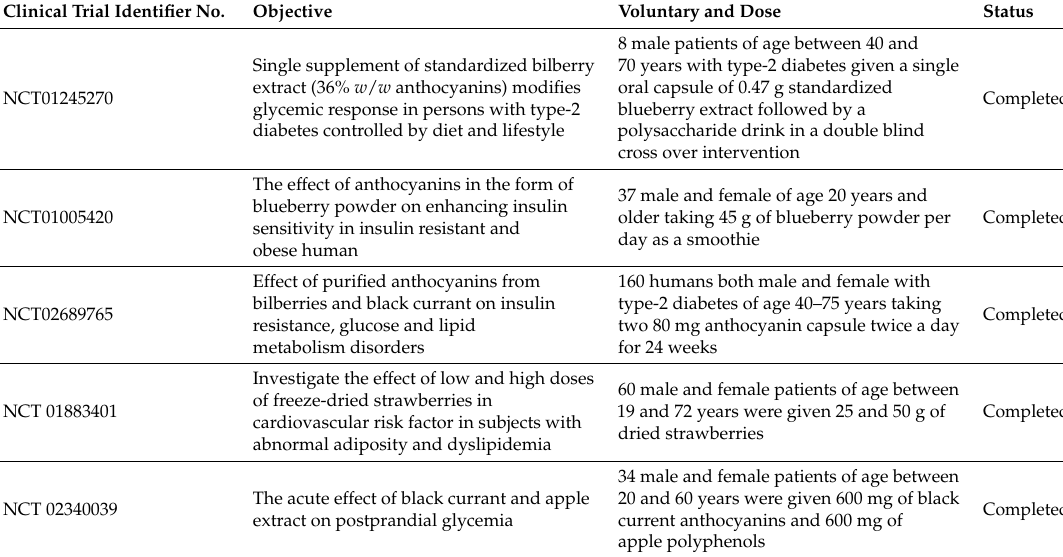
Table 4. Current clinical trials on anthocyanins as potential therapy against insulin resistance and/or